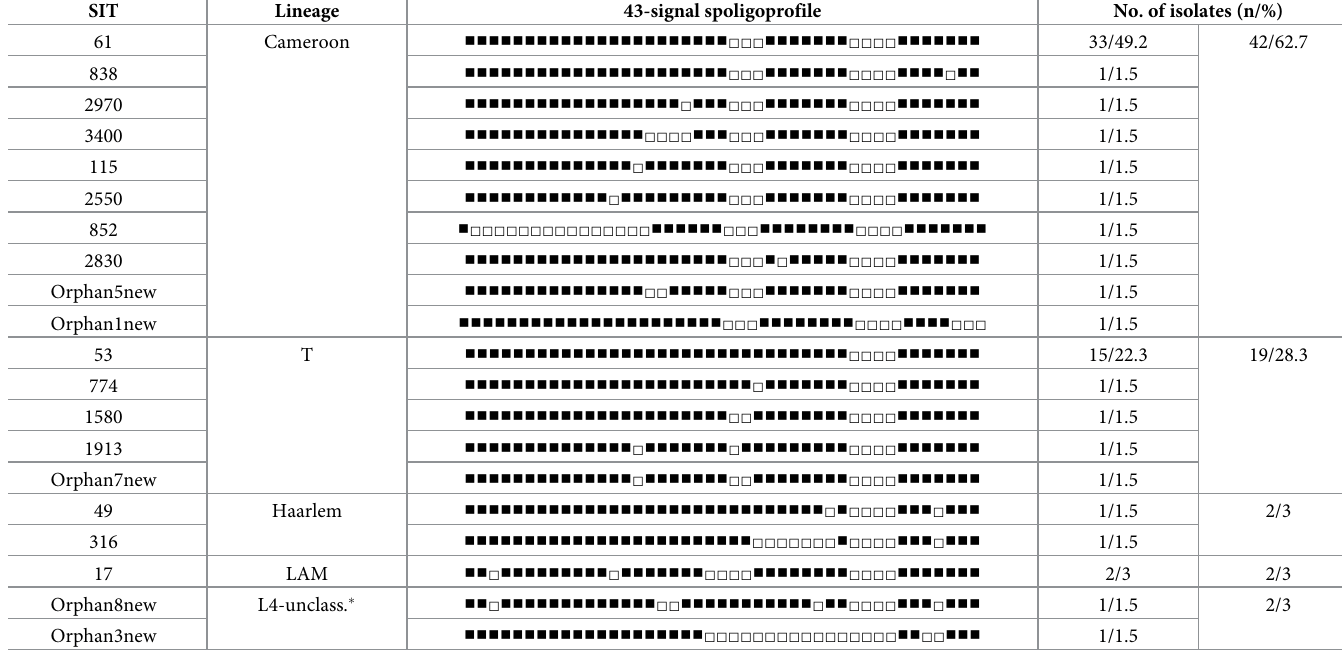
Table 2. Spoligotype-based diversity of 67 M . tuberculosis isolates under the